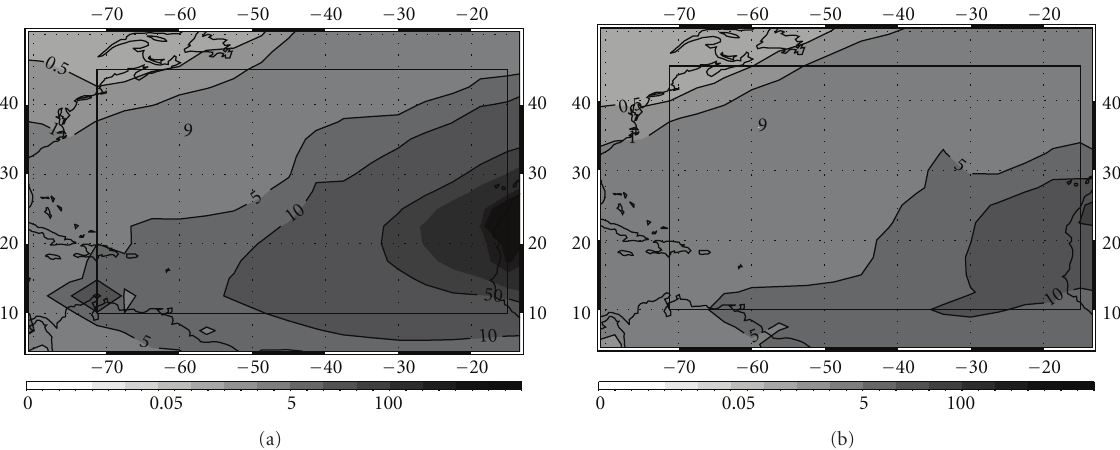
Figure 6: Deposition into the North Atlantic (g m − 2 yr − 1 ) for (a) CLIM and (b) DEAD. The box and the “9” correspond to the box and DIRTMAP observation location given in Figure